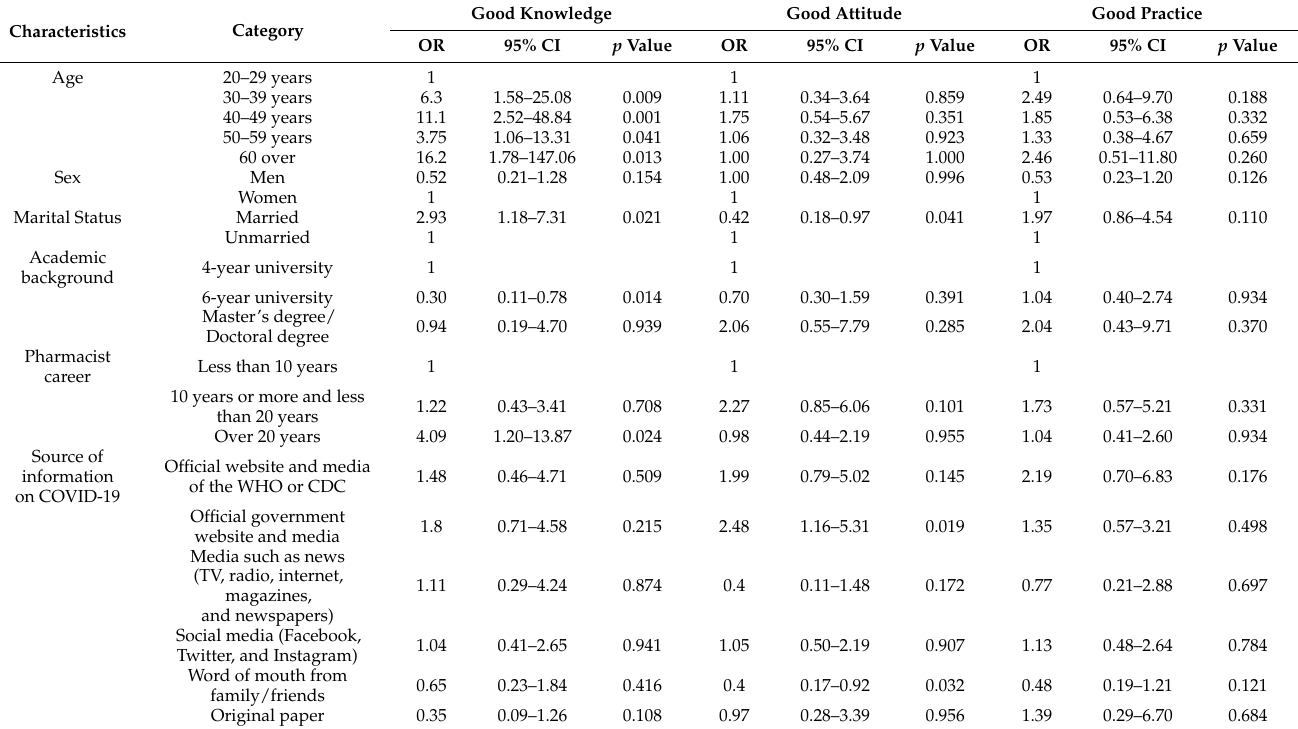
Table 6. Evaluation of attribute factors related to KAP using univariate logistic regression